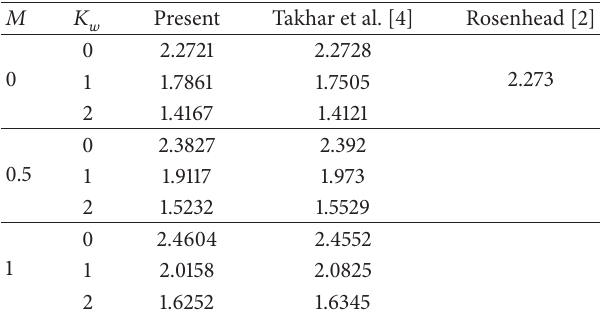
Table 2: Values of 𝑓 󸀠󸀠 (0) for different values of 𝑀 and 𝐾 𝑤 >